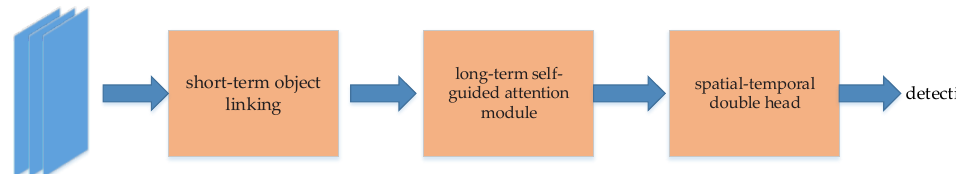
Figure 31. The workflow of Short-Term Anchor Linking and Long-Term Self-Guided Attention.